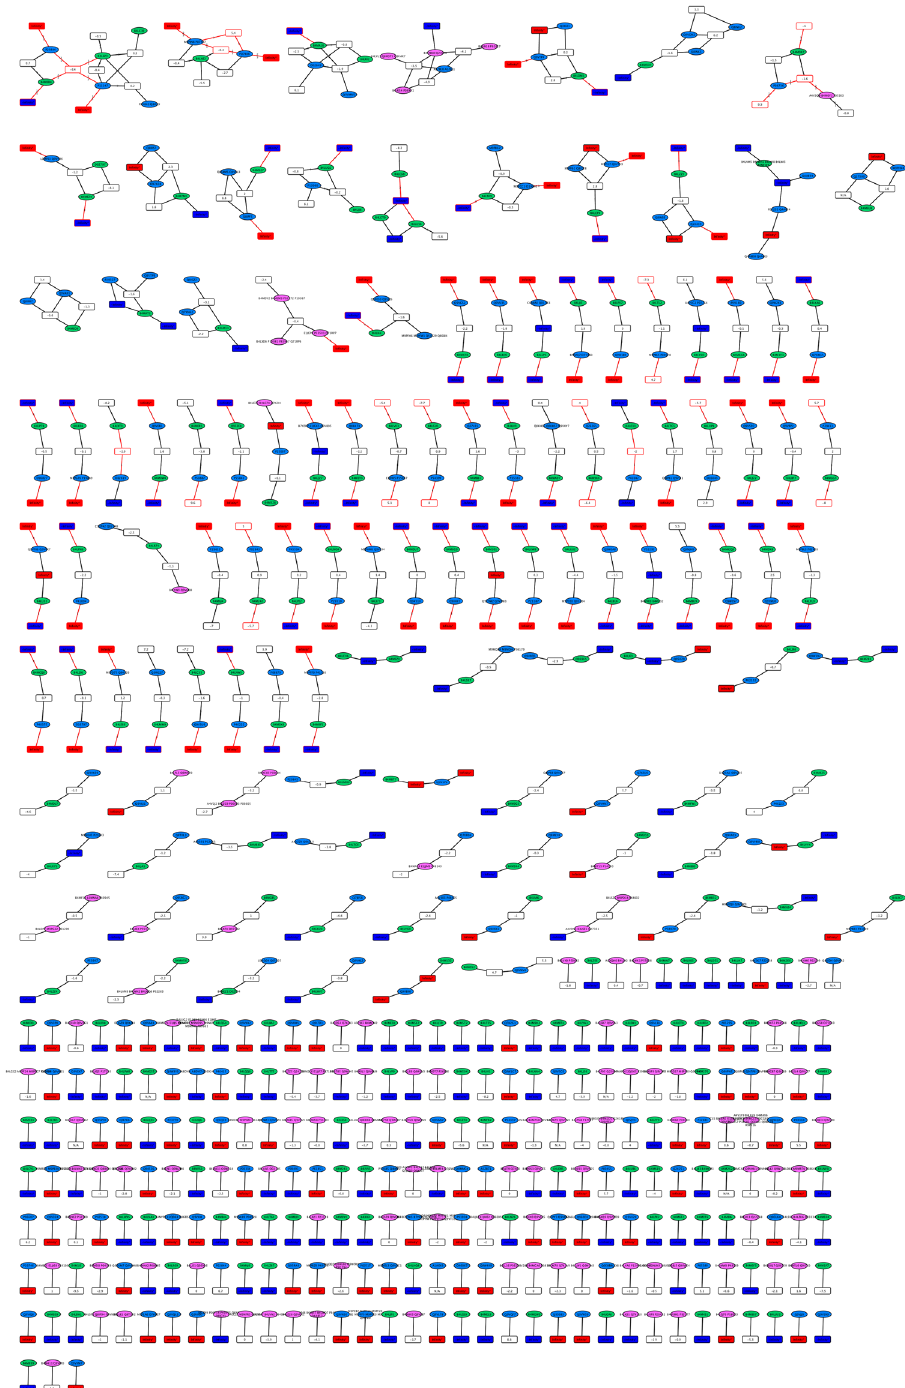
Fig. 2 Complete peptide-to-protein network in the D . melanogaster vs. D . virilis species comparison. The network shows redundant peptides or proteins in single nodes. Peptide nodes are displayed as rectangles and protein nodes are ellipses (blue for D . melanogaster , green for D . virilis ). Protein nodes comprising proteoforms of both species are shown in pink. Edges and peptide node outlines in red indicate that the relative quanti fi cation signi fi cantly deviates from the additional peptide nodes in a protein pair within a peptide-to-protein cluster. Relative abundance of peptide nodes is in the two-sample comparison is color-coded: peptide nodes in white, red, or blue are measured with a ratio, + ∞ ( + INF), or − ∞ ( − INF), respectively. The network is available online: Network the size of the network, primarily through additional, single peptide-to-protein clusters. The output of PCQ conveniently represents the proteome as a bipartite peptide-to-protein network that also reports the difference in abundance of a peptide node in the two samples.